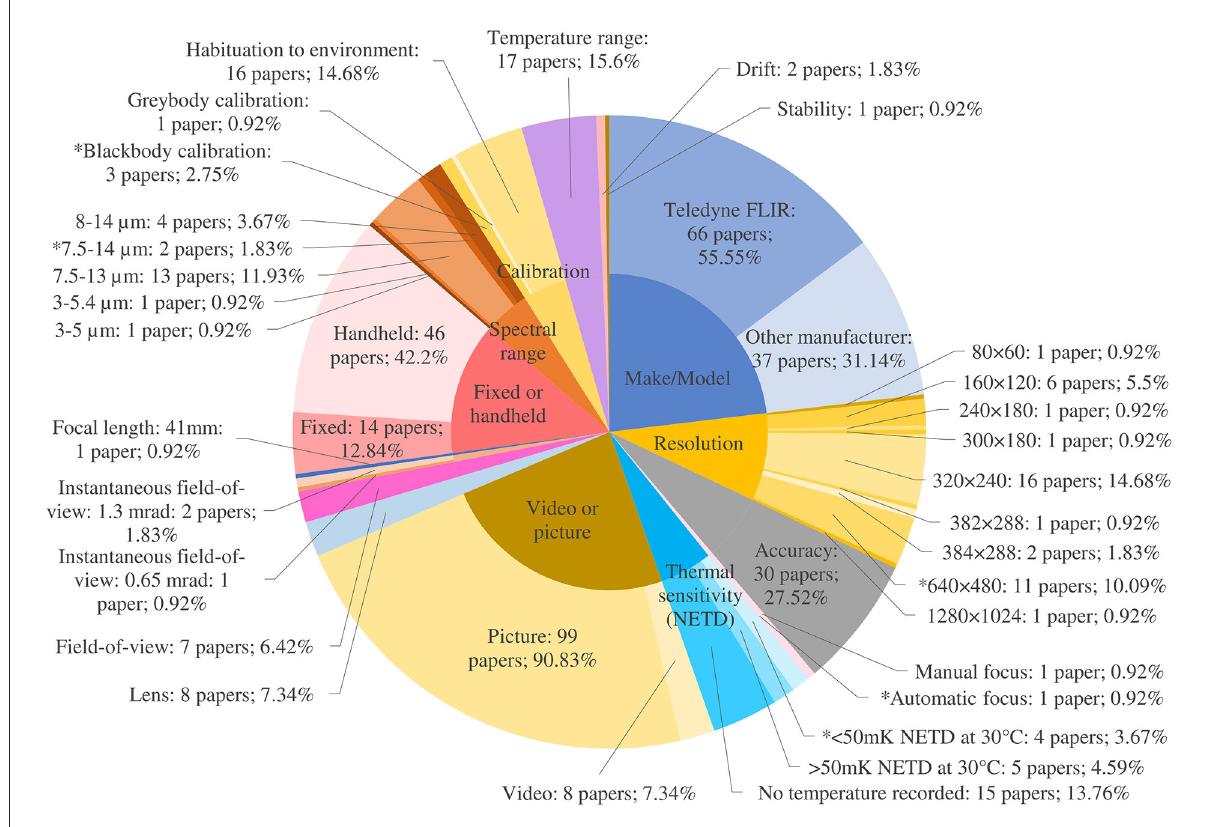
FIGURE6 Camera parameter reporting where * denotes the recommended value. Recommended values for instantaneous field-of-view and spot size are 2.6 mRad and 2.1 2.0mm (3 3 or 9 pixels) at 40cm distance from the animal ≤ × ×